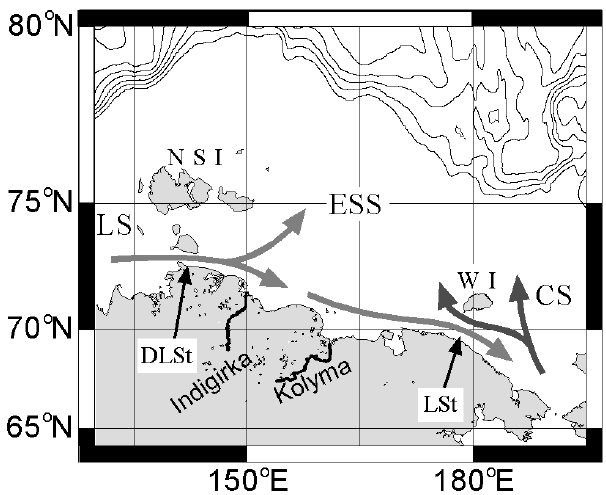
Fig. 1. Map of the East Siberian Sea with illustration of the Siberian Costal Current following the coast to the east and the inflow of low salinity water from the Laptev Sea (LS) to the northwest of the ESS and the inflow of water from the Chukchi Sea (CS) to the northeast of the ESS. The mouth of the two largest rivers, Indigirka and Kolyma, entering the ESS are noted, as well as the New Siberian Islands (NSI), Wrangel Island (WI), Dmitry Laptev Strait (DLSt) and Long Strait (LSt).